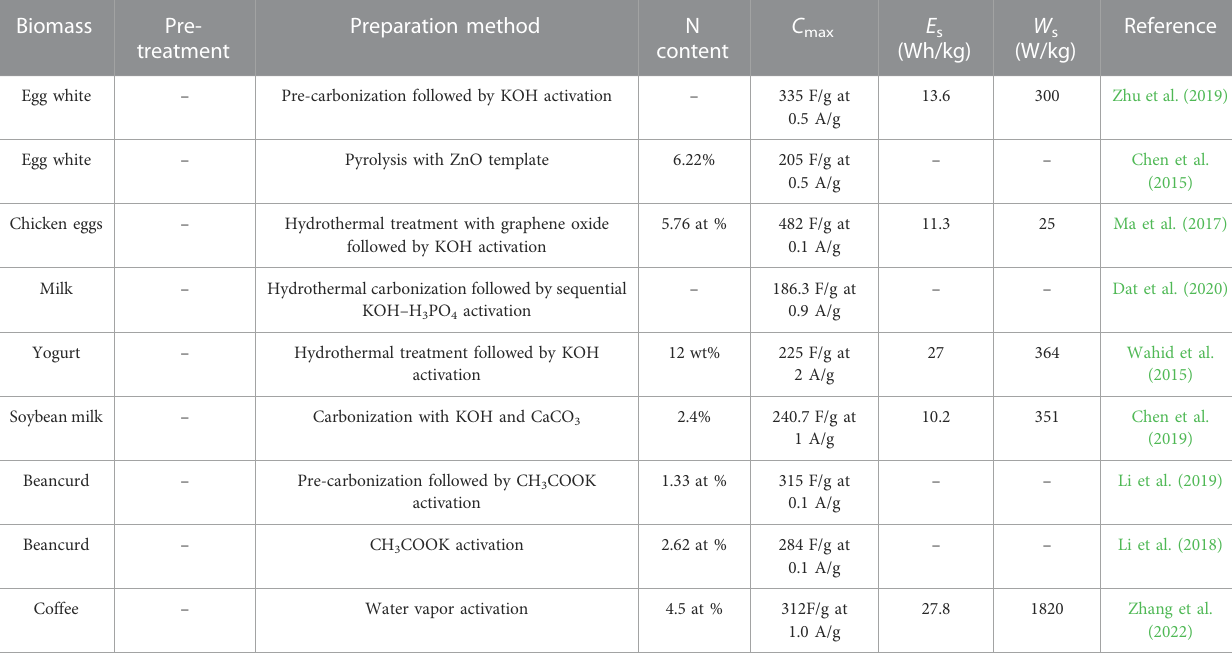
TABLE 3 Food-based N self-doped biochar applications in supercapacitors. Biomass Pre-